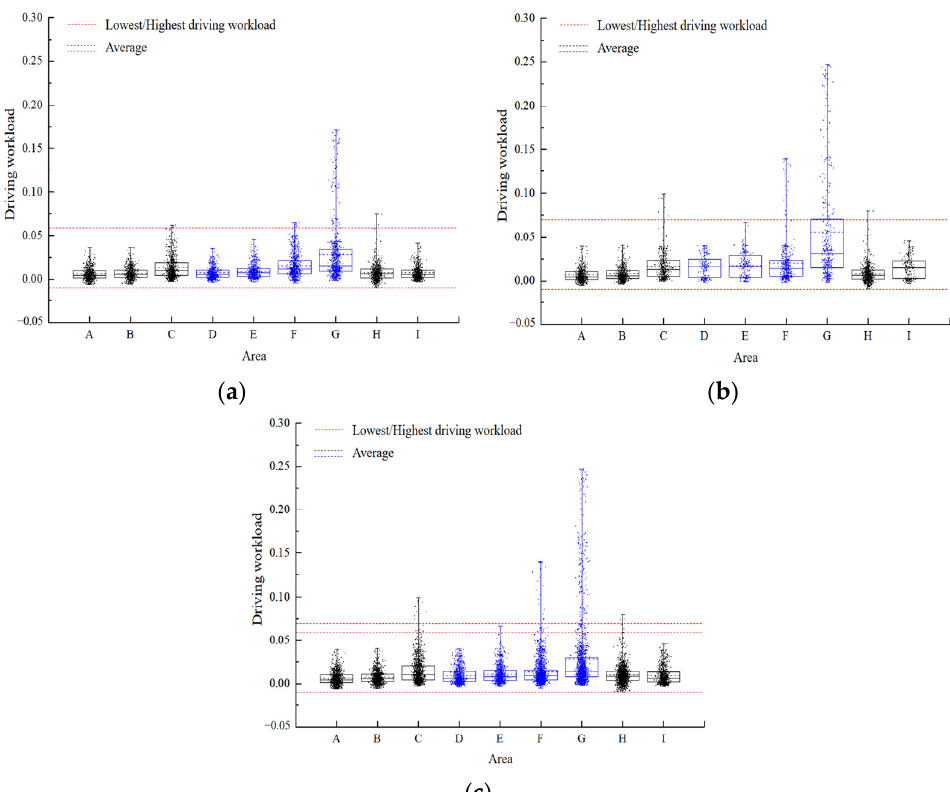
Figure 8. Distribution of driving workload for different areas and vehicles. ( a ) Passenger car; ( b ) truck; ( c ) all vehicles.